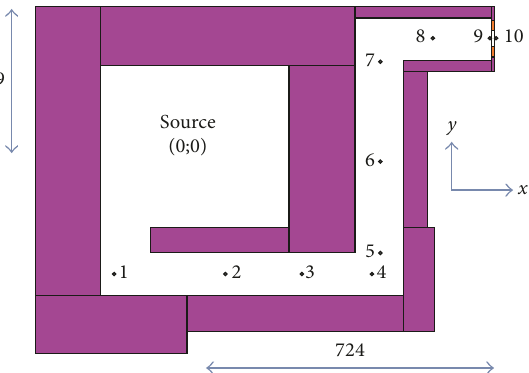
Figure 4: MCNPX model 𝑋𝑌 view of the Gamma Irradiation Laboratory with localizations of points